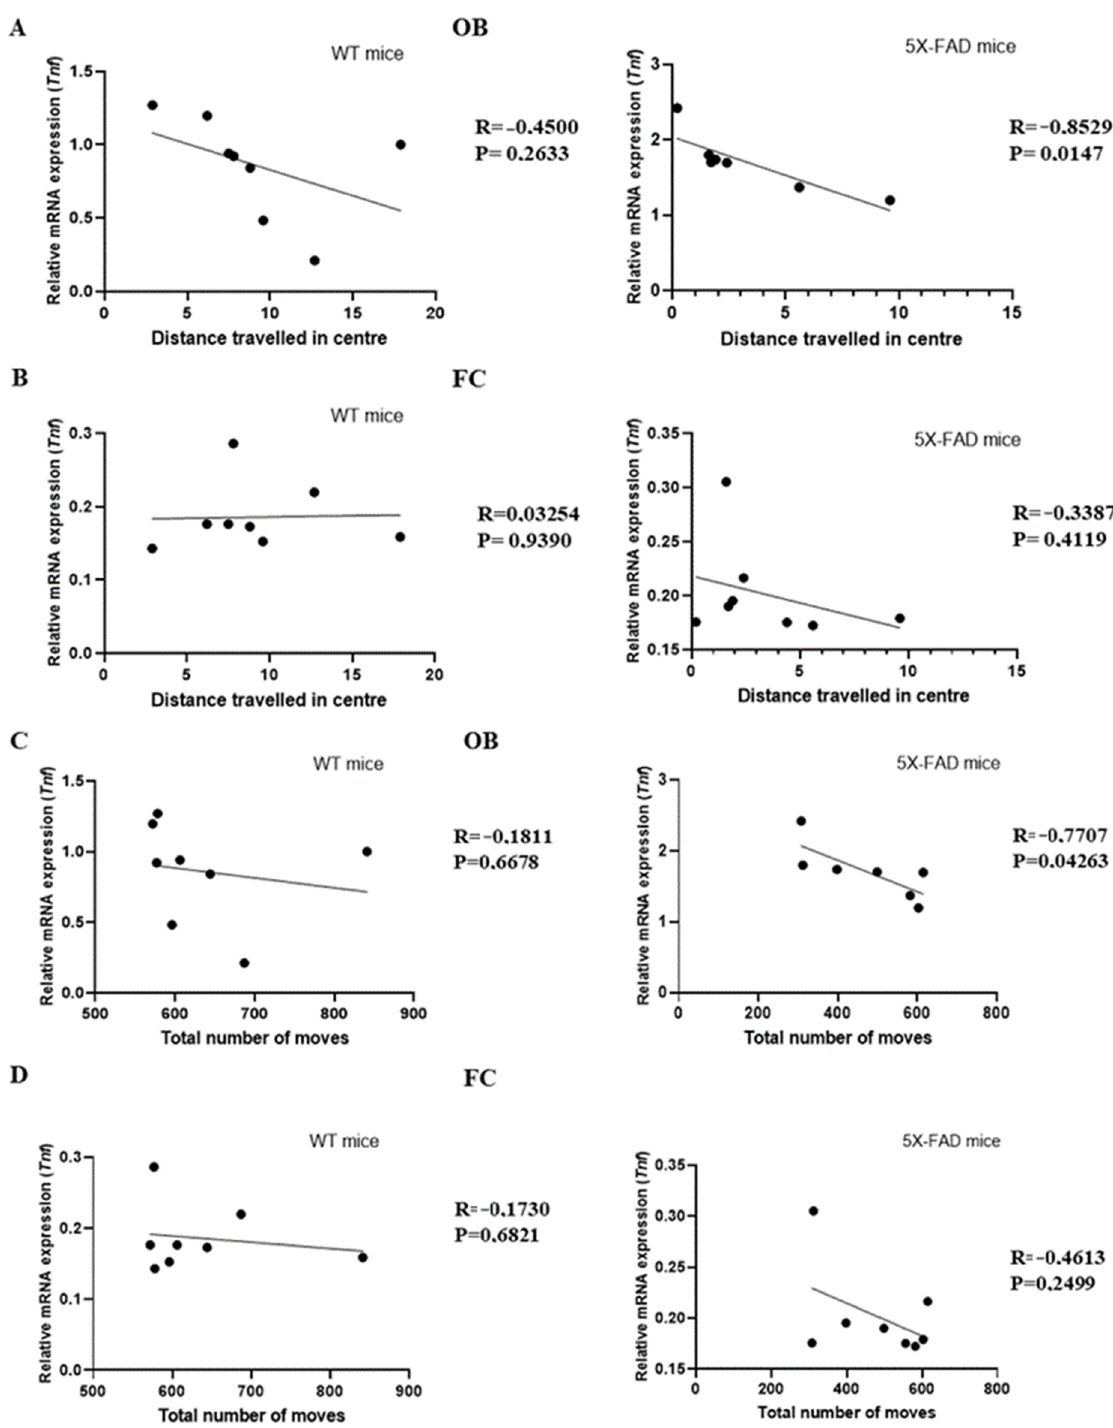
Figure 3. Correlations of the pro-inflammatory cytokine Tnf in the OB with anxiety of 2 mo 5×FAD male mice. Tnf mRNA level in the OB but not FC was negatively correlated with distance traveled in the center ( A , B ) and total number of moves ( C , D ) in open field in 5×FAD mice, while no correlations were present in WTs ( n = 8) (Pearson’s test).